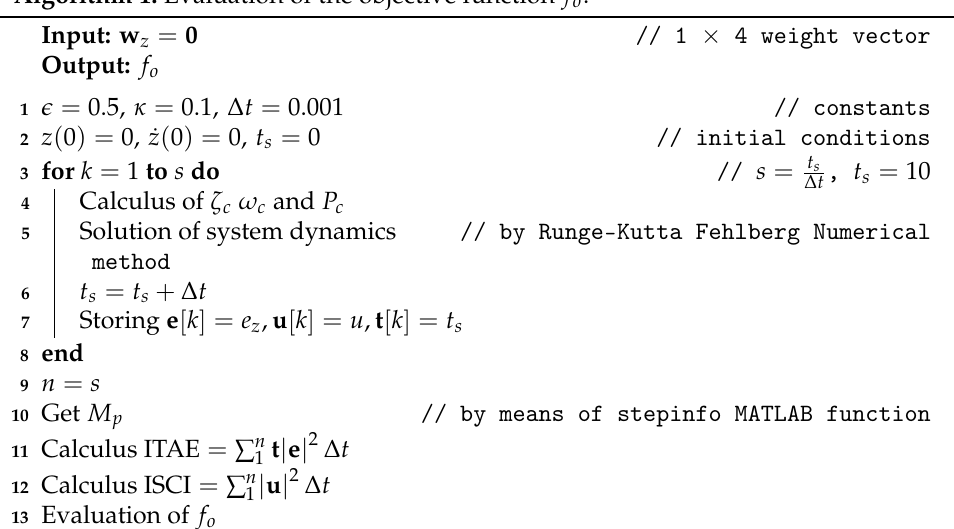
Algorithm 1: Evaluation of the objective function f o